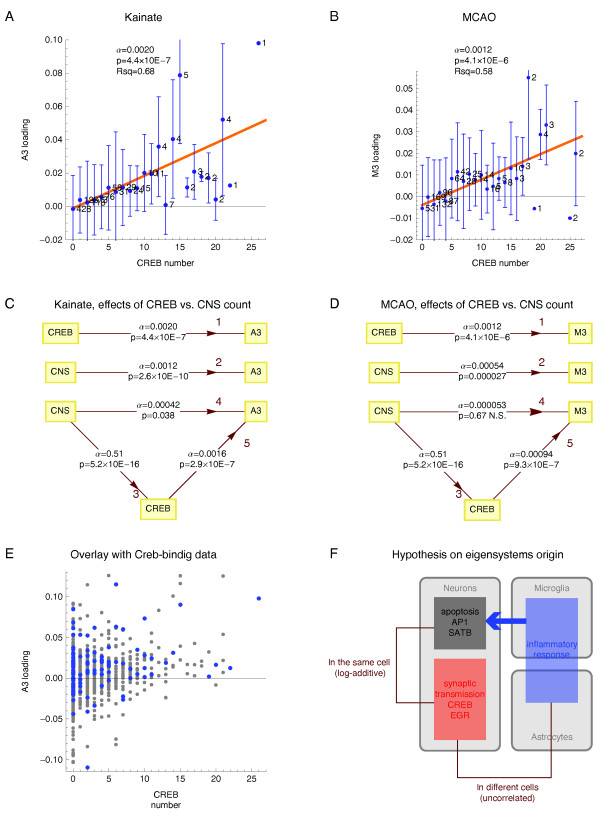
Effects of CREB motif count on gene expression in the subspace of the conserved eigensystem 3 (A, B) The effects of CREB motif count per gene on the average loadings of the eigensystem A3 or M3 analyzed by weighted linear regression, as described in the legend to Figure 6. (C, D) Effect of CREB count and direct and indirect (via CREB count) effect of CNS count per gene on the average loadings of eigensystems A3 or M3 analyzed by weighted linear regression, either univariate (edges 1, 2, 3) or bivariate (edges 4, 5), in groups of genes with the same numbers of CNSs, CREB motifs, or both. The results are represented as path analysis graphs, with each edge marked by the values of the respective linear regression directional coefficient α and its corresponding t-test p-value. In the univariate regression of CREB count on CNS count (edge 3) the data for all the genes with at least one CNS in the TRAM database were used. (E) The single gene A3 loadings and CREB counts for all the genes with CNS(s) in the kainate dataset (grey dots) compared to the values the Creb-binding genes in PC12 cells identified by genome-wide ChIP analysis by Impey et al. [50] (blue dots). (F) Uncorrelated, additive effects of the motifs SATB and CREB on gene log-expression provide an insight into the biology of the MCAO system.